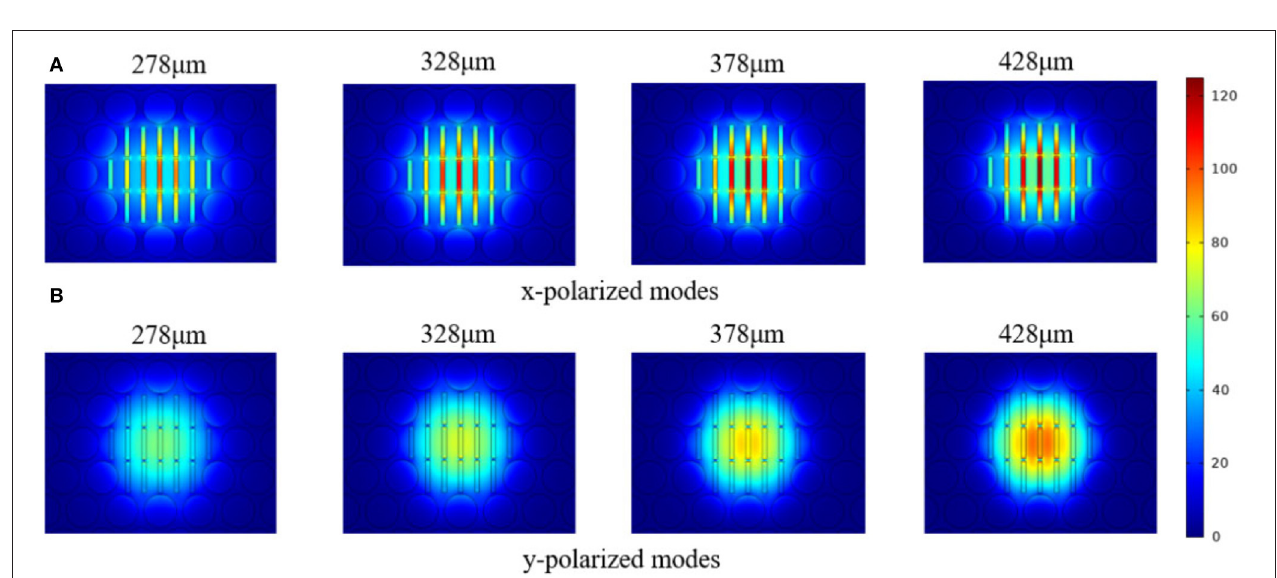
FIGURE 1 | Cross-section of the PCF THz waveguide, and an enlarged view of the porous-core area.